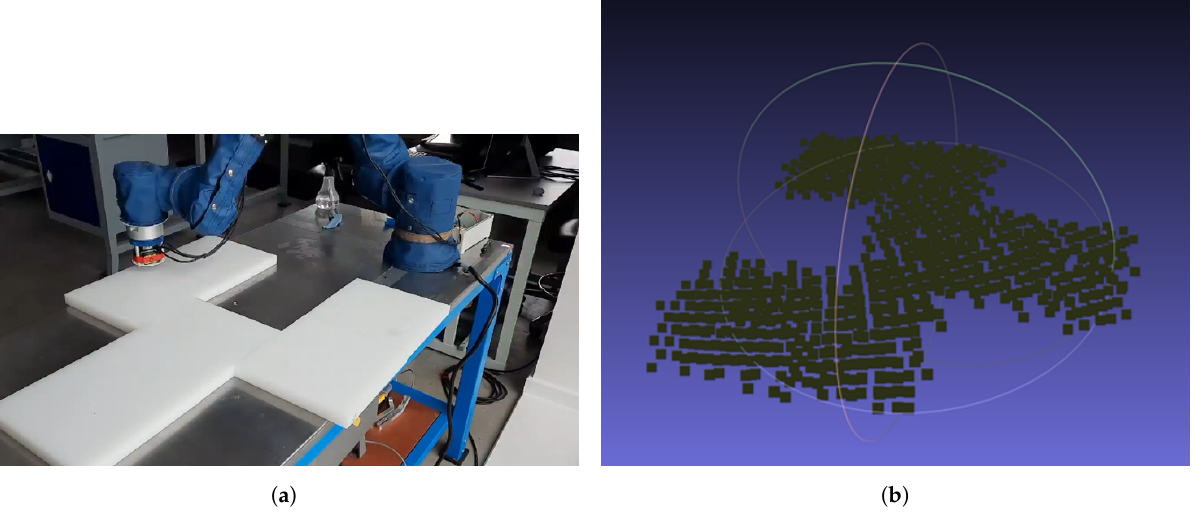
Figure 12. Automatic online profiling and scanning of an object with non-smooth shape. After a new point is found, the UT probe is applied to collect data. ( a ) Non-smooth shape created from arranged plates. ( b ) Resultant point cloud collected by the tri-laser and projected to the World-Frame using the live Joint-position of the